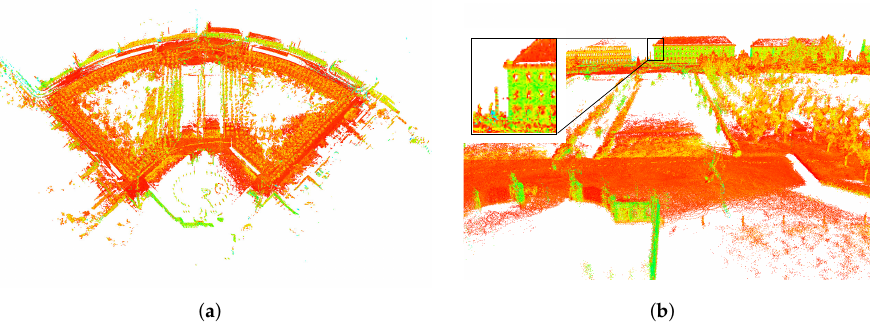
Figure 11. Mapping results of our approach on Schloss-2 , which are rendered based on the intensity value: ( a ) top view, ( b ) side view. Our method produces a map with fine details, especially in the magnified region of ( b ).